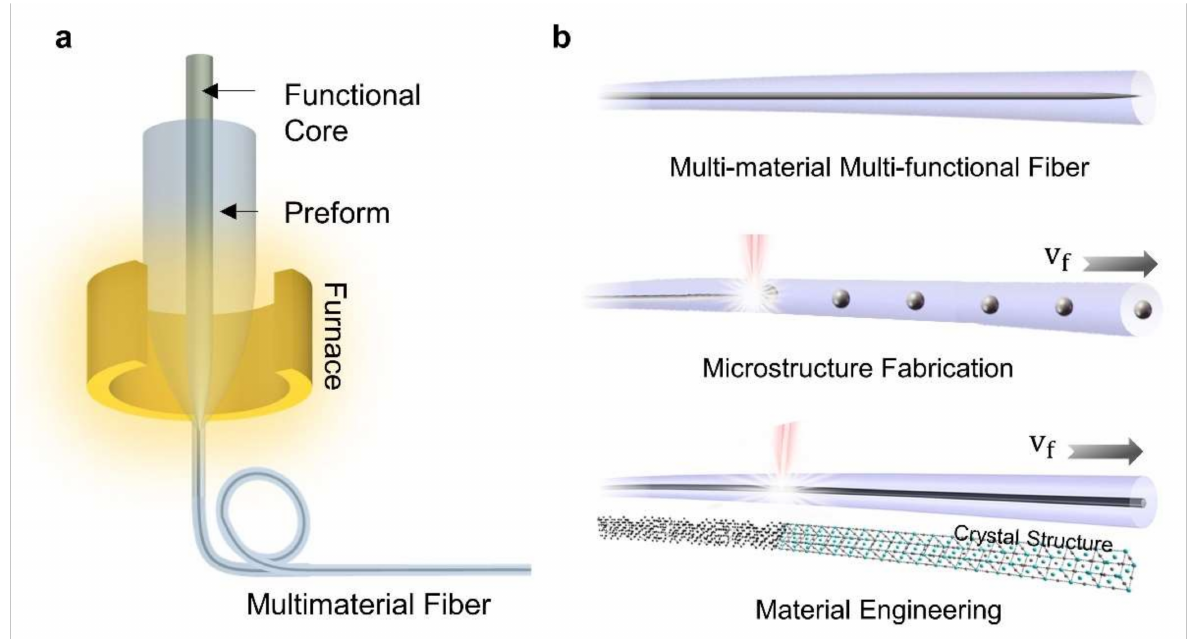
Figure 7. Schematic of multi-material fiber thermal drawing method and in-fiber thermal treatment processing. ( a ) Schematic of advanced fiber thermal drawing process. ( b ) In-fiber microstructure generation process and material engineering